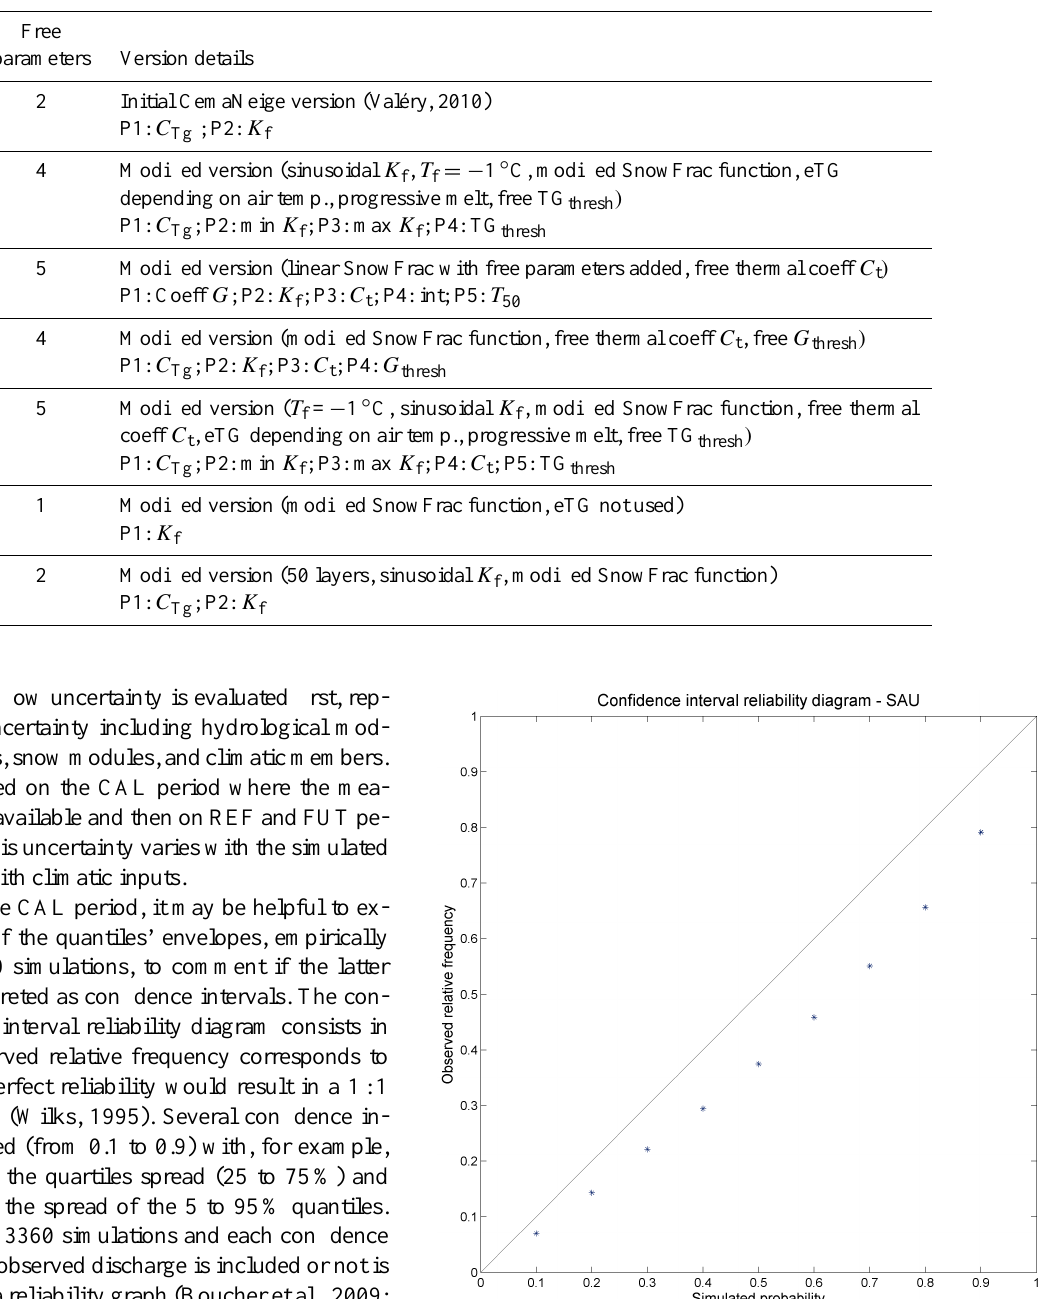
Table 3. List of the seven snow module versions and free-parameters.